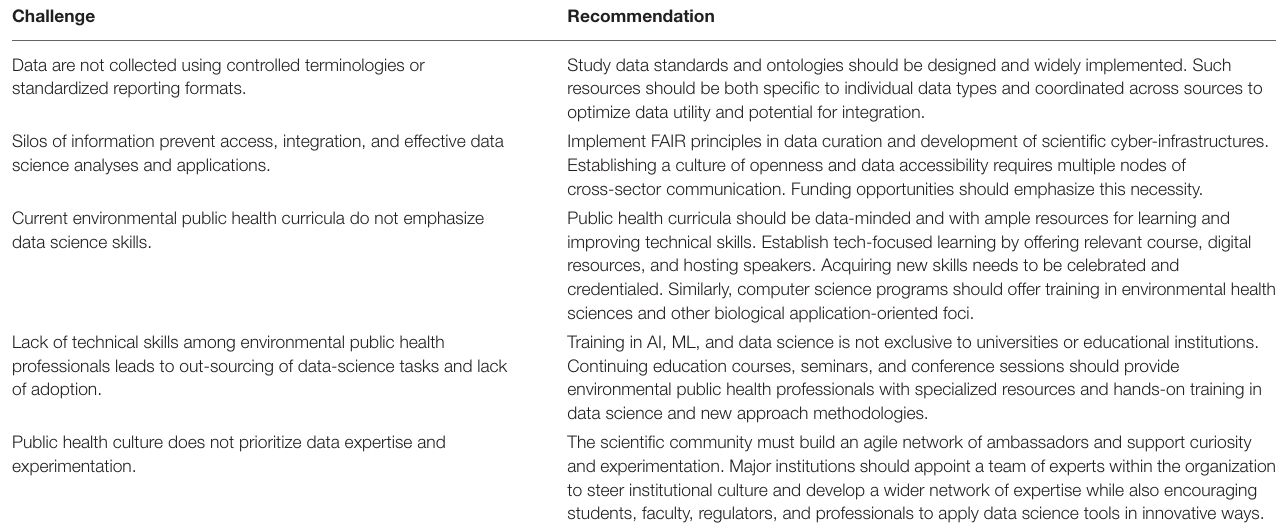
TABLE 1 | Challenges and recommendations for fostering the big data revolution in environmental public health, summarized here and detailed in text. Challenge Recommendation Data are not collected using controlled terminologies or standardized reporting